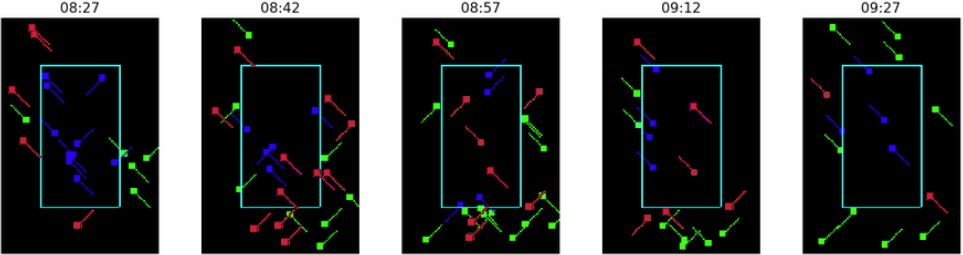
Figure 5. Representation of the RL system outcome for the regulation YBOLN07 .